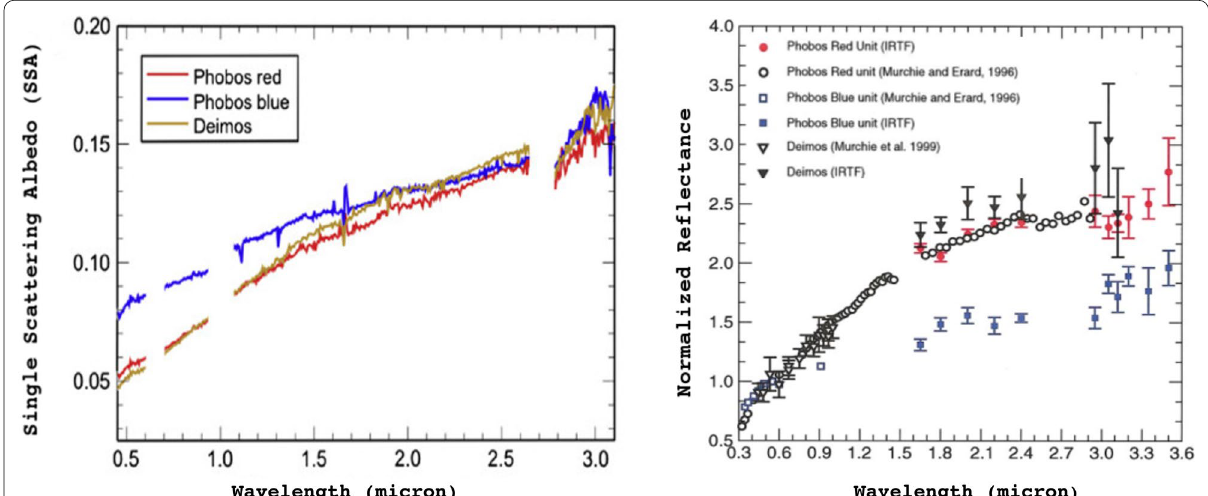
Fig. 1 Left: single scattering albedo spectra (SSA) for the Phobos blue and red units, and for Deimos, derived from CRISM‑MRO spectra, extracted from Fraeman et al. (2014). Right: combination of several spectra covering the 0.3–3.6 μm range of Phobos and Deimos, extracted from Rivkin et al.